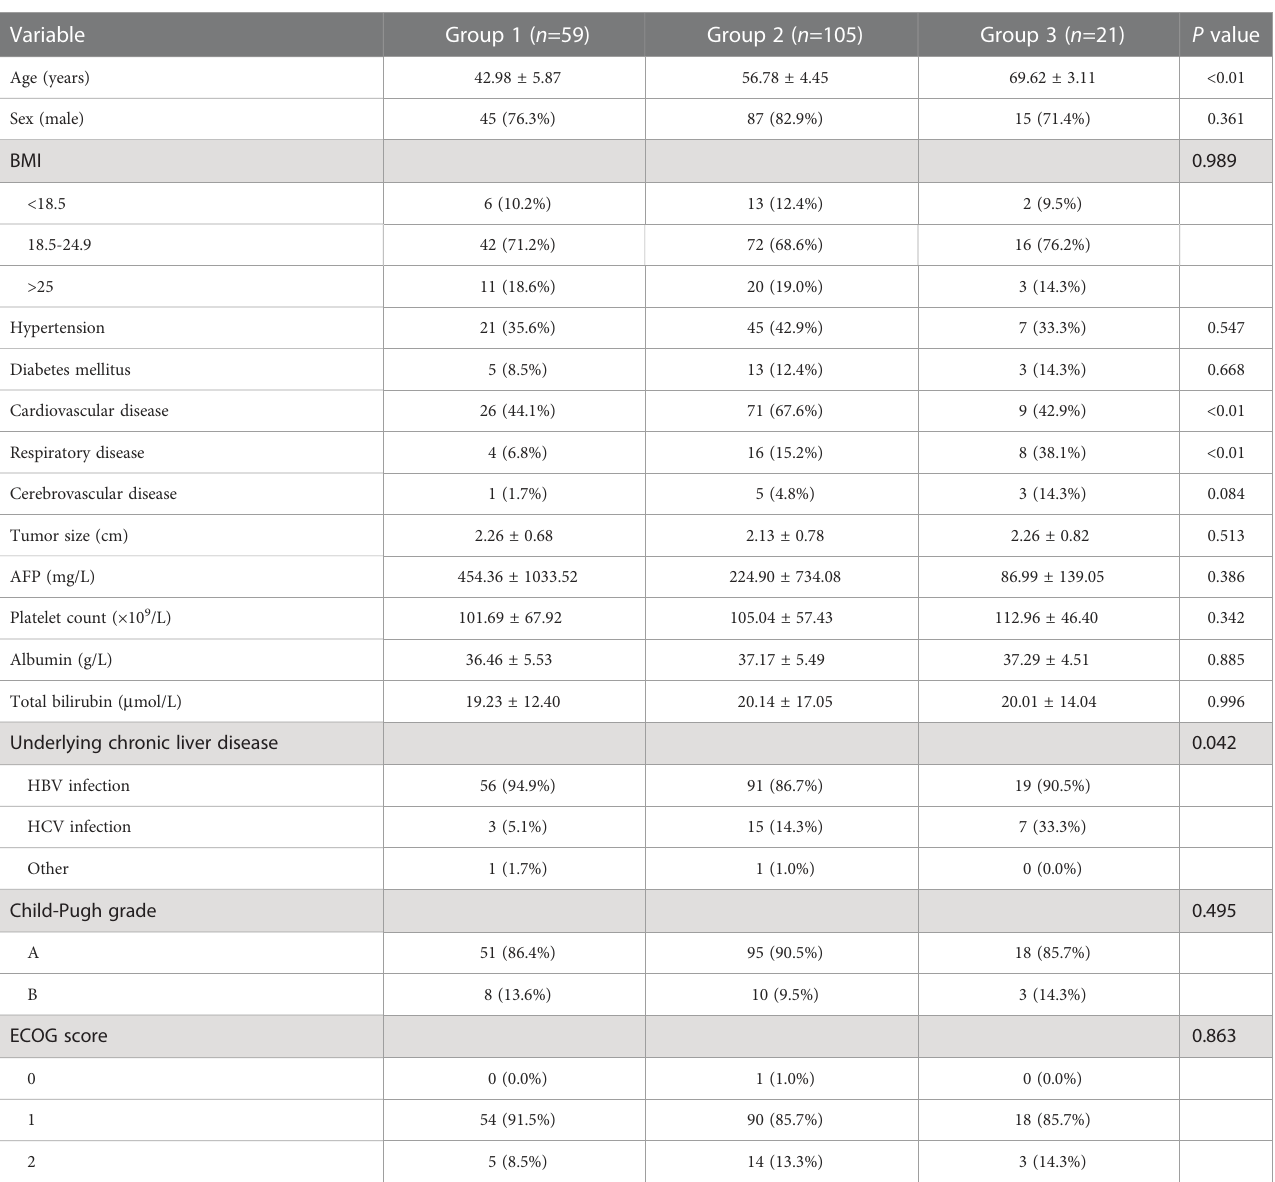
TABLE 1 Baseline characteristics of included